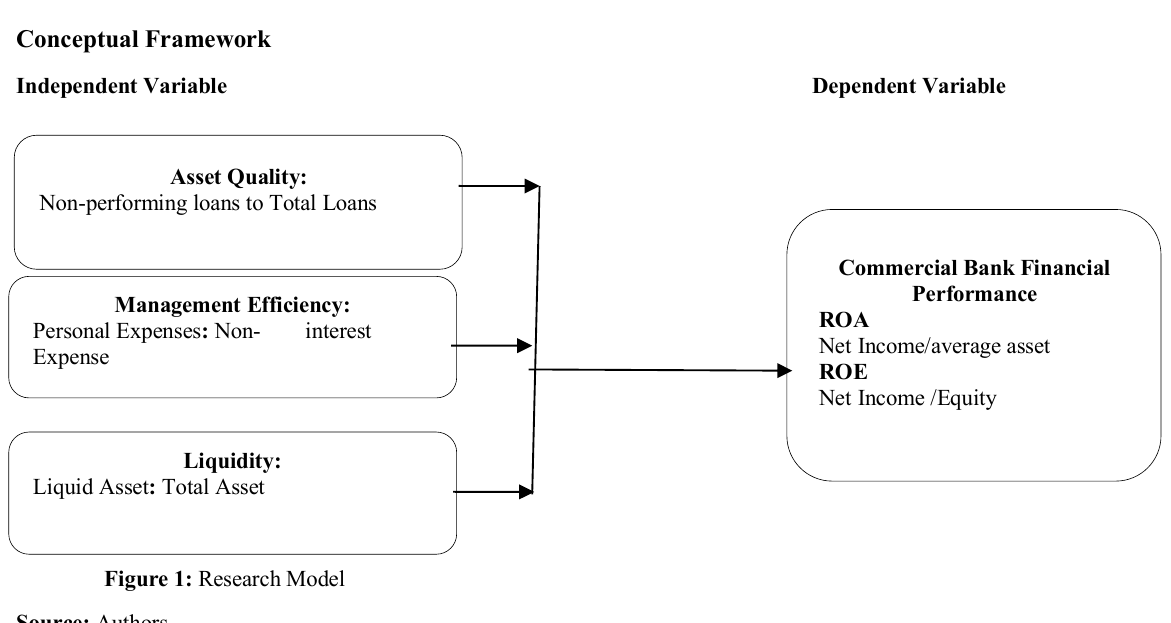
Figure 1: Research